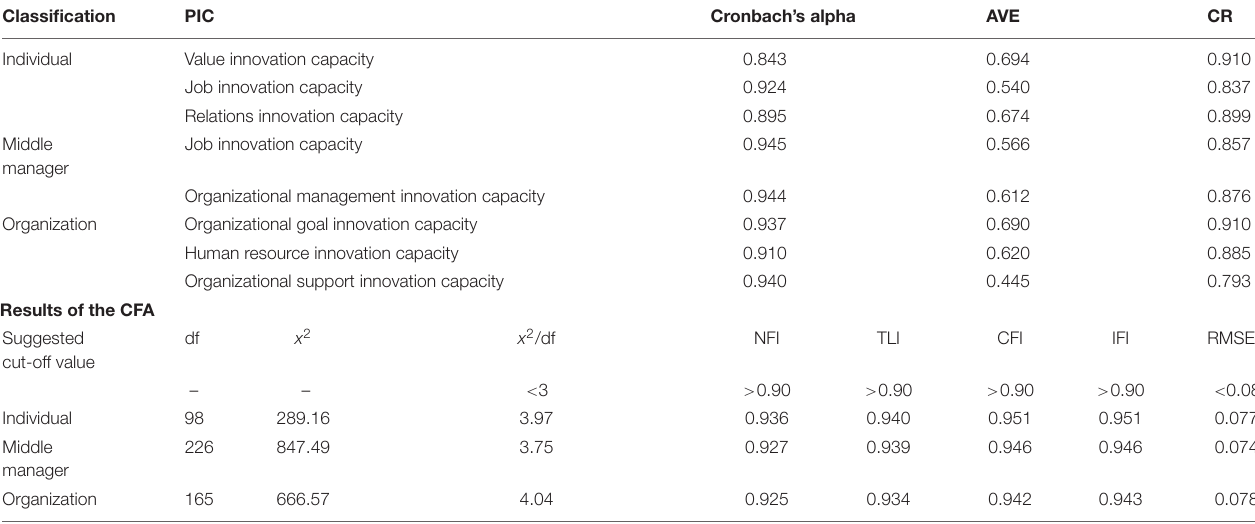
TABLE 4 | Results of the reliability and validity